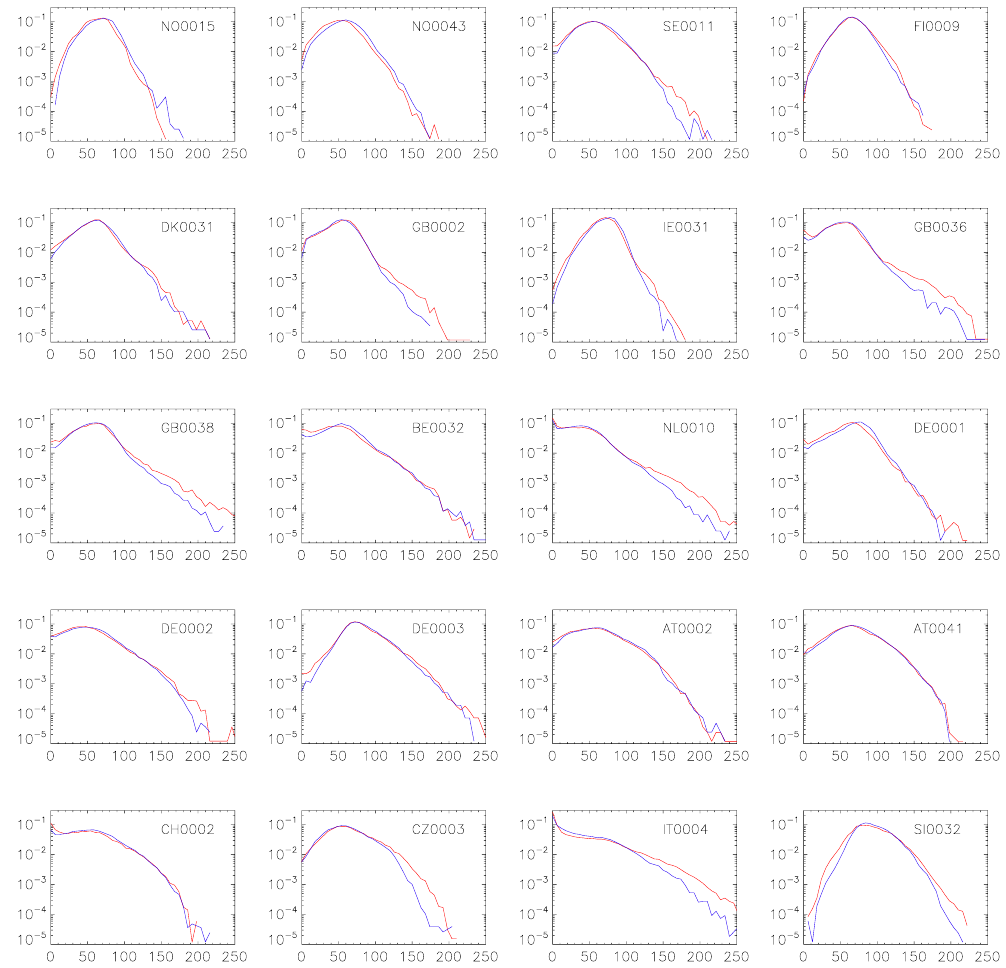
Fig. 16. Frequency distribution of hourly ozone concentrations for selected EMEP sites (Appendix A) (arranged by region from north to south) for the periods 1990–1999 (red) and 2000–2009 (blue). X-axis: µgm − 3 , y-axis: frequency. Binsize: 6µgm − 3